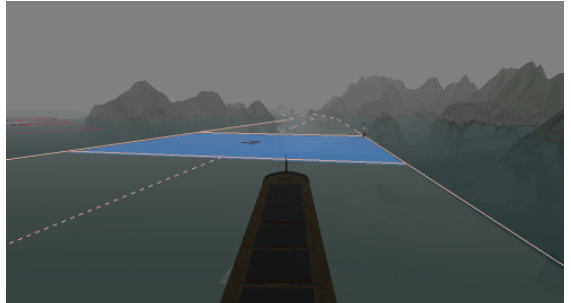
Figure 5. Night and fog